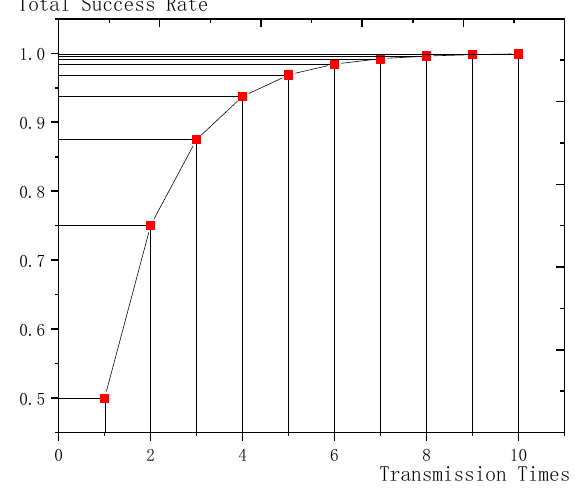
Figure 7. The example of Theorem 1 ( (cid:1842) (cid:3047)(cid:3045)(cid:3028)(cid:3041)(cid:3046) = 0.5).